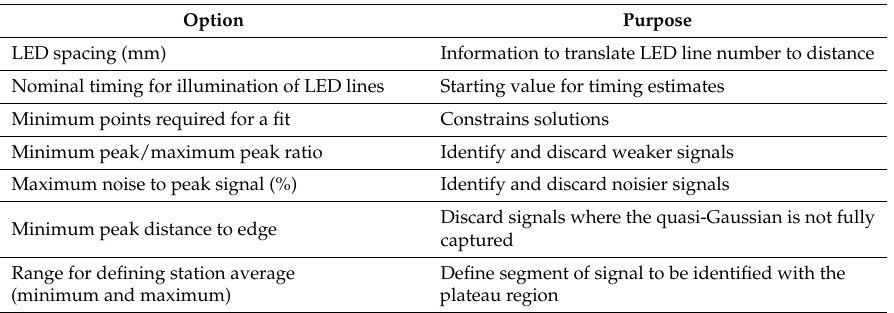
Table 1. User-specified options for GUI.